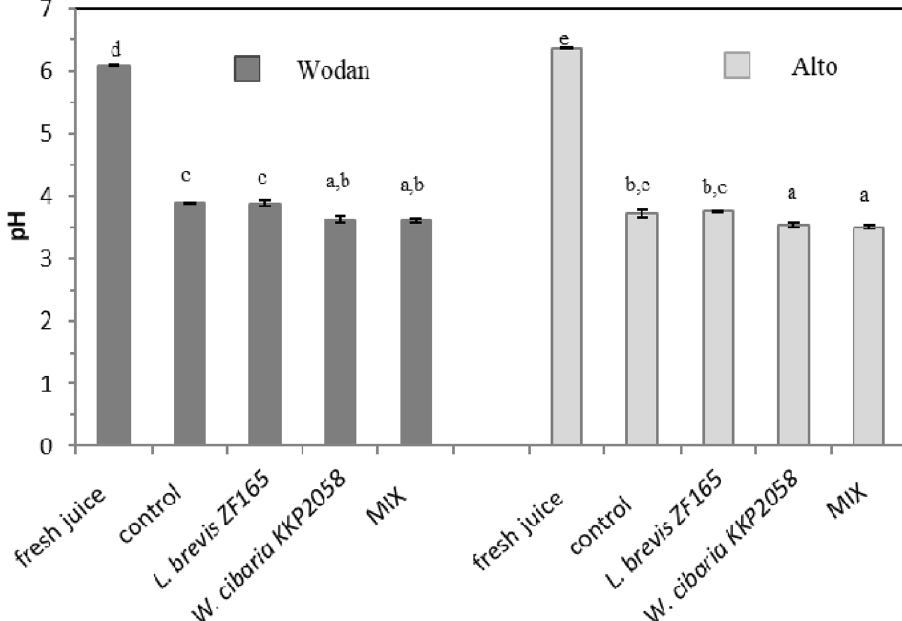
Figure 1. pH of fresh and fermented juices of Wodan and Alto variety. MIX i.e. five-strain starter culture (containing W. cibaria KKP2058, L. brevis ZF165, L. plantarum KKP1822, L. fermentum KKP1820, and Leuconostoc mesenteroides JEIIF). The results are expressed as mean ± SD. Different letters show significant differences between obtained values ( p < 0.05), according to Tukey’s HSD test. Control refers to samples fermented spontaneously with native